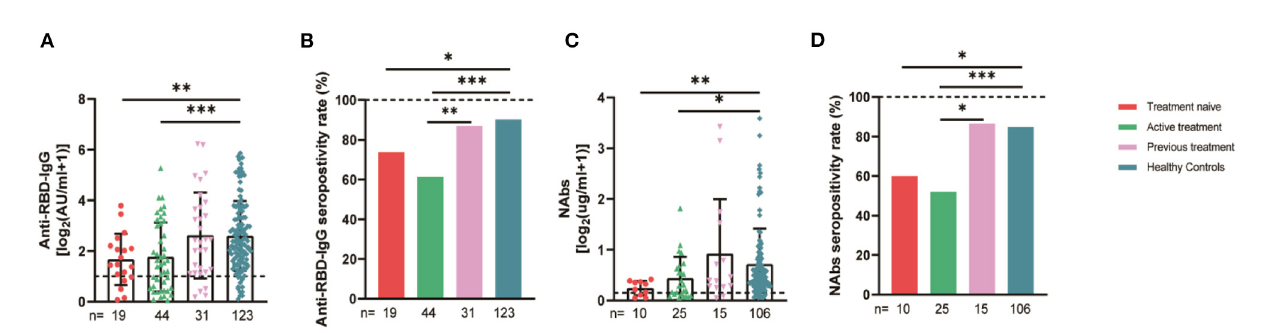
FIGURE8 Antibody response to SARS-CoV-2 vaccine in breast cancer patients with different treatments status. Subgroup analysis of the titers and seropositivity rate of anti-receptor binding domain (RBD)-IgG (A, B) and NAbs (C, D) in participants according to different treatments. The horizontal dotted lines represent the limit of detection. The error bars represent the median. (IQR) (* P < 0.05, ** P < 0.01, *** P < 0.001). NAbs, neutralizing antibodies; IQR, interquartile range; RBD, receptor binding domain. *Chemotherapy, molecularly targeted therapy, or radiotherapy within 6 months after or before vaccination was considered active anticancer therapy. *A person is considered to be treatment-naive if they have never undergone treatment for a particular illness.